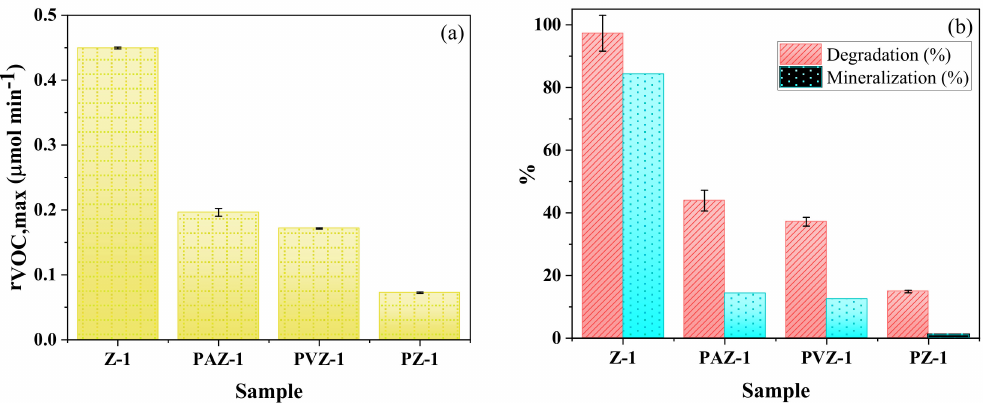
Figure 7. ( a ) Maximum n -decane conversion rate ( r VOC,max ) and ( b ) degradation and mineralization for samples Z-1, PAZ-1, PVZ-1, and PZ-1. Conditions: irradiation intensity = 245.5 W m − 2 ; C VOC,feed = 78.8 ppm; Q feed = 150 cm 3 min − 1